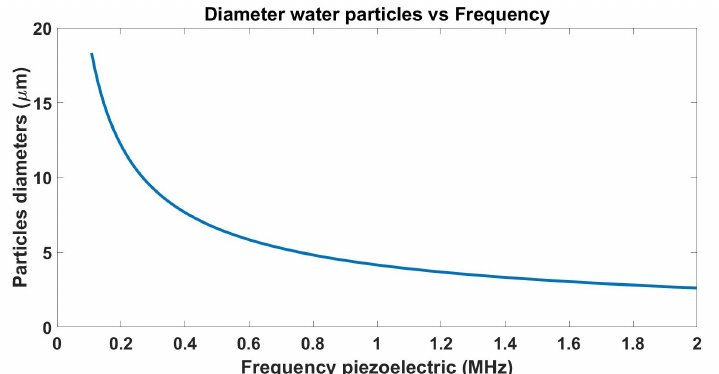
Figure 5. The operating range (108.3 kHz to 1.7 MHz) of the piezoelectric generates fog particles with mean diameters between 3 and 180 µ m .